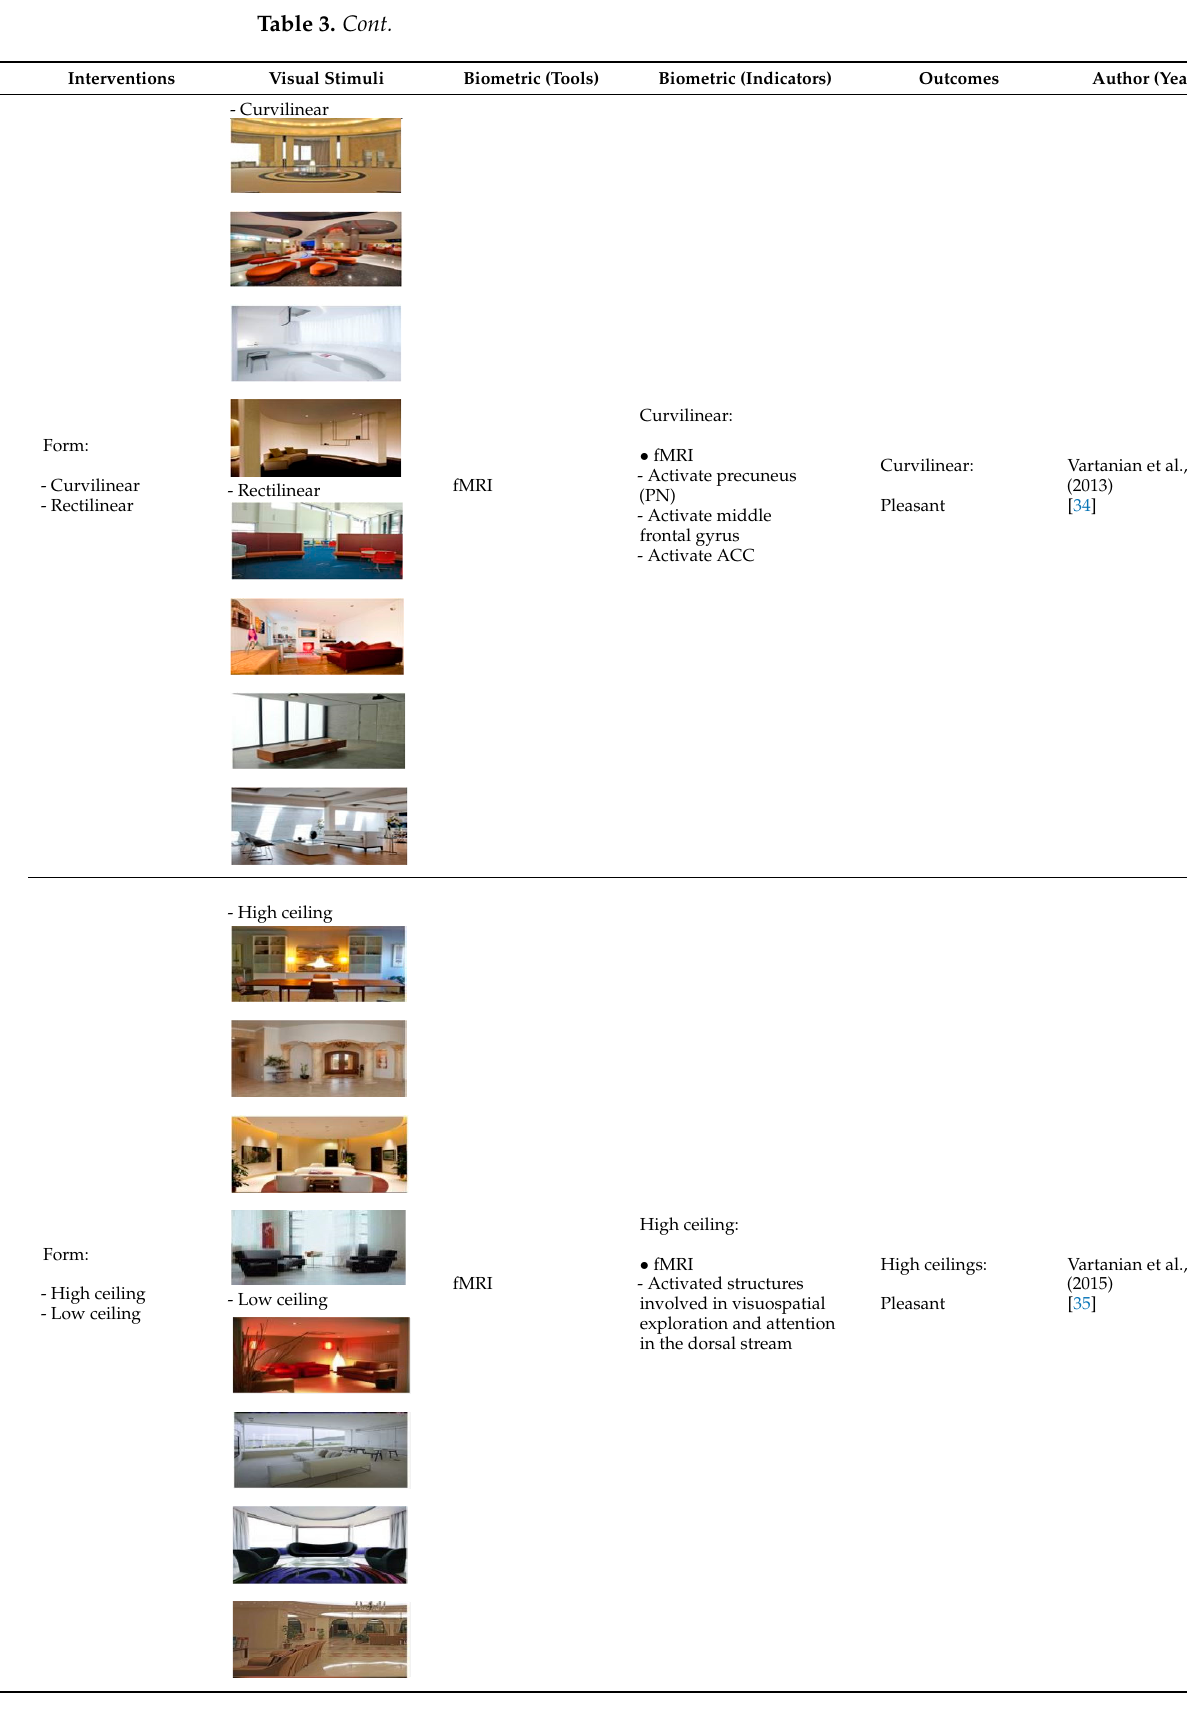
Table 3. Summary of design variables, biometric tools, and outcomes. 3.4.1. Effects of the Design Characteristics on Emotions The outcomes showed a positive relationship between design interventions and emo- tional responses in architectural environments. Furthermore, the findings showed that types of design characteristics could cultivate positive emotion in built or virtual environ- ments. • Curvilinear forms (unlike rectilinear) engender a higher experience of pleasure and are correlated with positive ratings [25, 31, 34]. Proportion is also a design element that affects a participant’s emotional assessment. An interior with a golden ratio prin- ciple accompanies a pleasurable experience [33]. Low complexity for low-fashion- involvement group and high complexity for high-fashion-involvement group engen- der higher experiences of pleasure [23]. For the composition of constituent elements, diverse and less fragmented scenes inspire positive feelings [40]. The visual